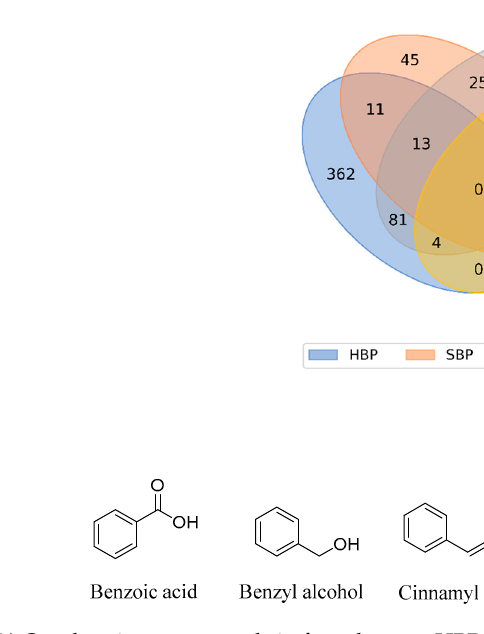
Figure 9. ( A ) Overlapping compounds in four datasets HBP, SBP, FC and DB; ( B ) Chemical structures of the four HBP compounds present in both FC and DB.